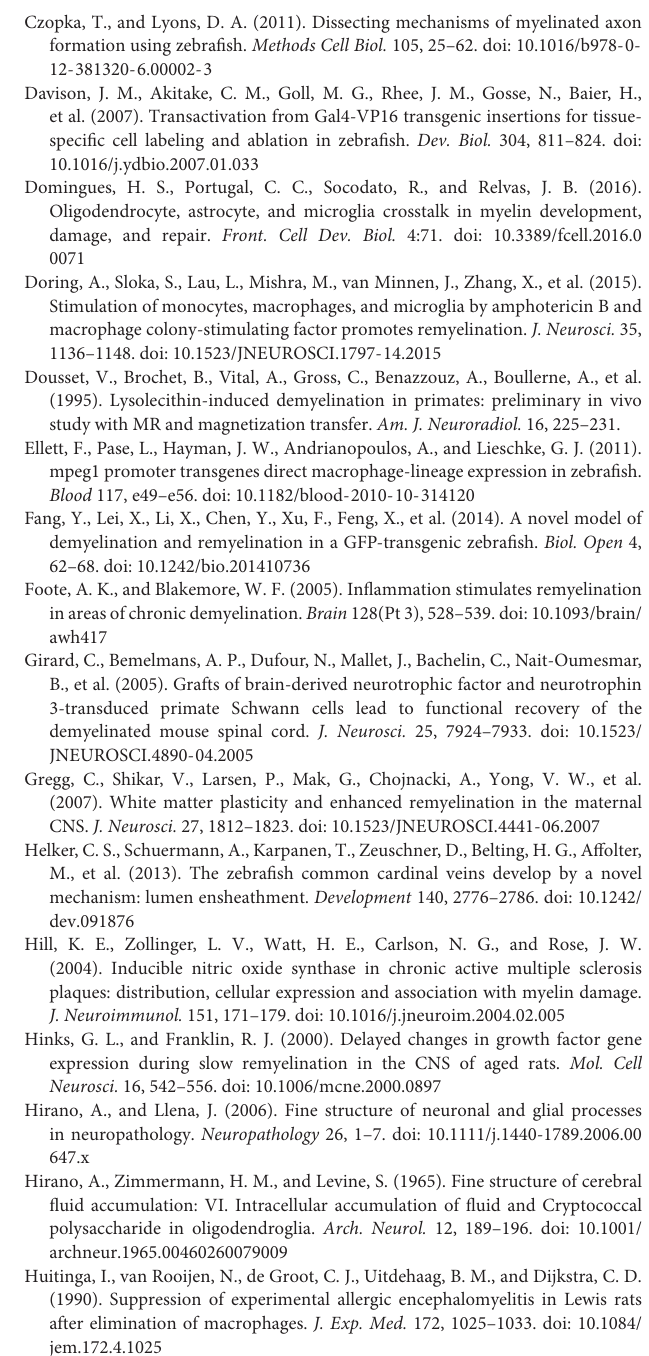
Tg(mbp:egfp-CAAX);Tg(mpeg1:mcherry) larvae imaged from 2 to 10 hpi. Images were taken every 15 min, and the movie runs at 10 fps. Supplementary Movie 4 | mpeg + phagocytes engulf sox10 + debris in lysolecithin-injected spinal cords. Lysolecithin was injected into 6 dpf Tg(sox10:mrfp);Tg(mpeg1:egfp) larvae imaged from 2 to 20 hpi. Images were taken every 10 min, and the movie runs at 10